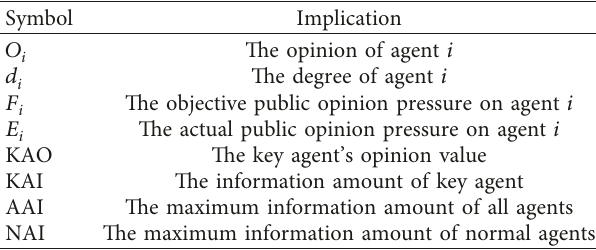
Table 2: Relevant important symbols.